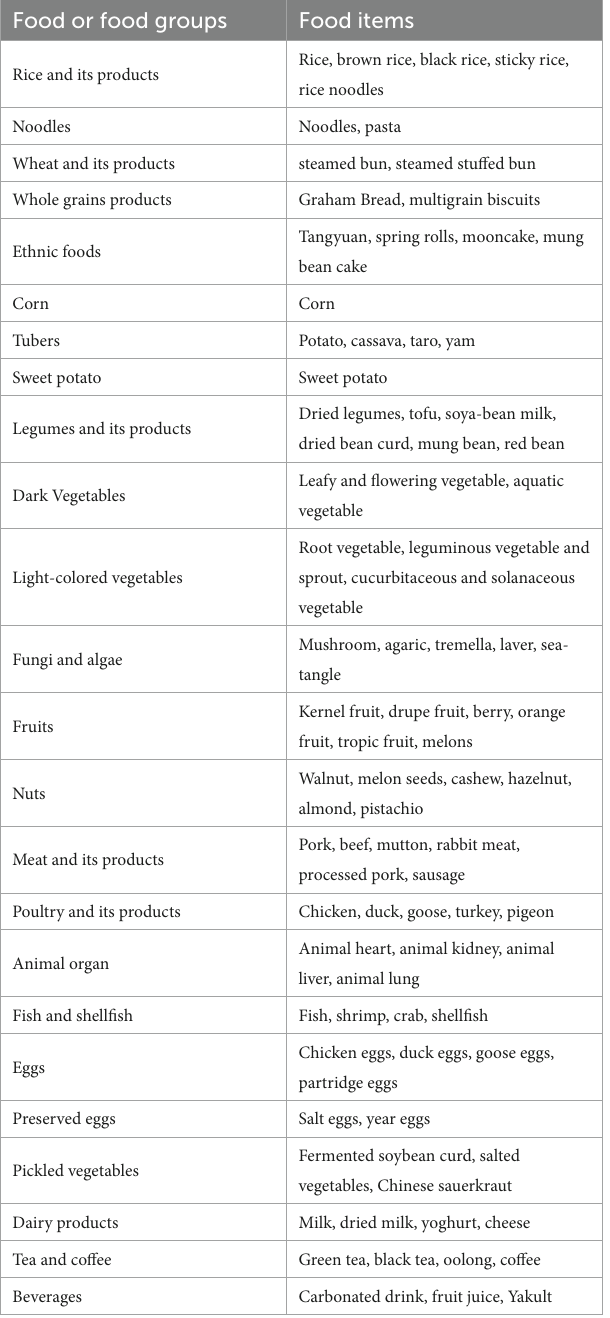
TABLE 1 Food or food groups used in the dietary pattern